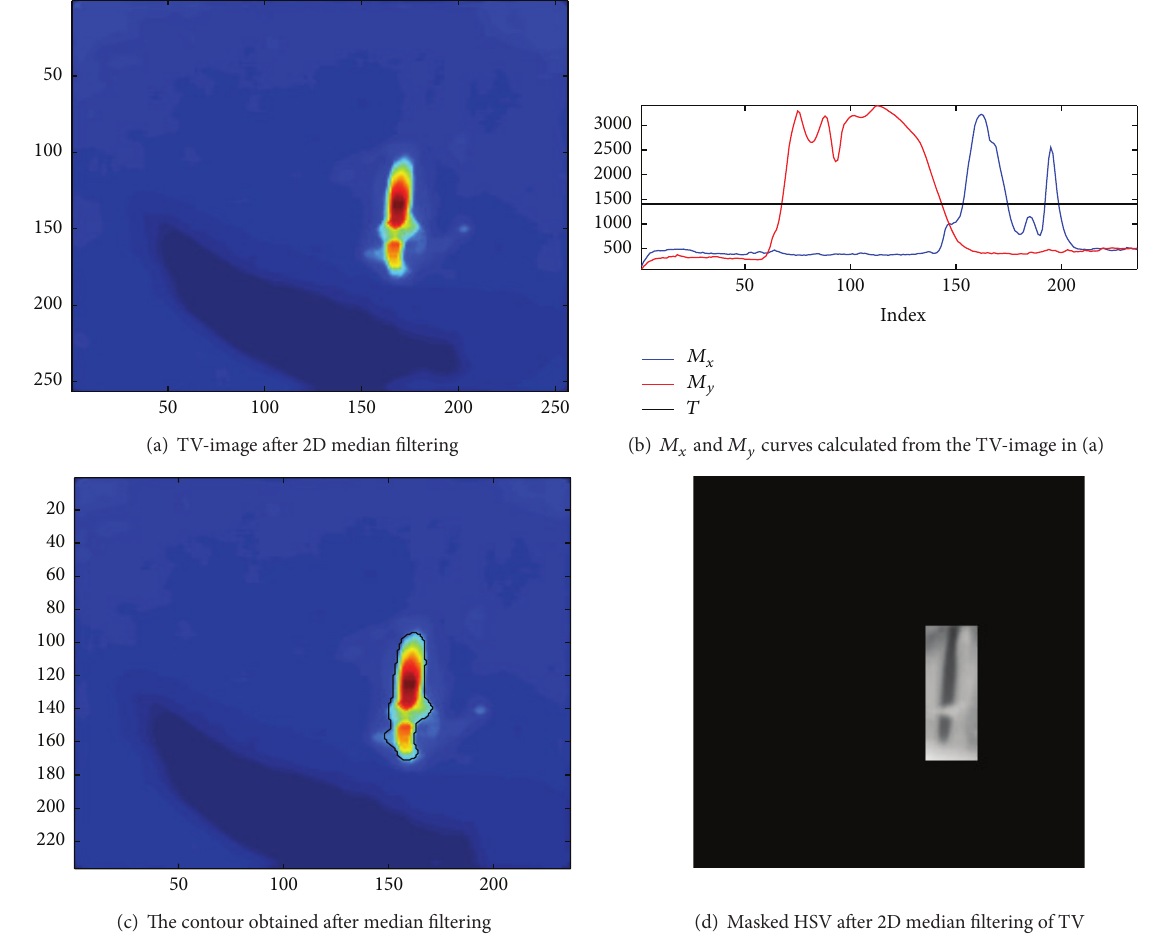
Figure 8: Application of the proposed method with 2D median filtering when glottis is separated into two regions.